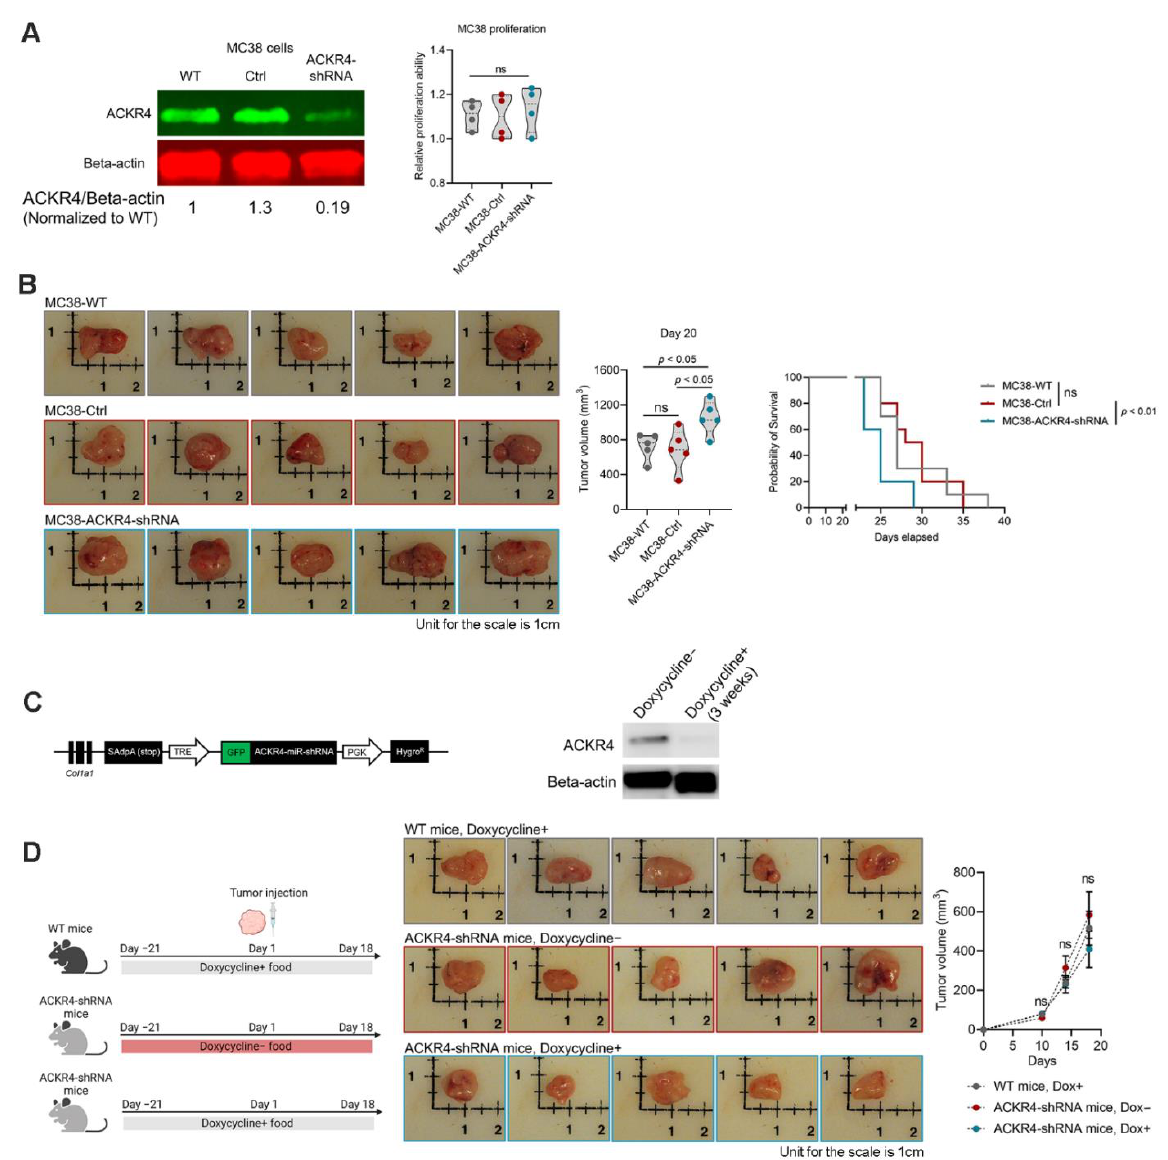
Figure 2. ACKR4 expression and tumor development. ( A ) Western blot analysis of ACKR4 knockdown in MC38 cell line (The grey area defines the data distribution. The dot lines in the violin plots indicate quartiles). ( B ) Knockdown of ACKR4 accelerated MC38 tumor growth in naïve C57BL/6J mice ( n = 5 for tumor growth analysis and n = 10 for survival analysis). ( C ) The induction and confirmation of ACKR4 knockdown in transgenic mice. Doxycycline treatment for 3 weeks significantly reduced ACKR4 expression in the mouse skin and subcutaneous connective tissue. ( D ) Knockdown of ACKR4 in the host mice did not significantly affect MC38 tumor growth ( n = 5). (For more than two group statistical analyses, the uppermost p -value indicates the ANOVA-analysis, and other p -values indicate the posthoc analysis between two specific groups. WT: Wild type, Ctrl: Control, shRNA: Short hairpin RNA, Dox: Doxycycline, Col1a1: Collagen, type I, alpha 1, GFP: Green fluorescent protein, Hygro R : Hygromycin resistance, PGK: Phosphoglycerate kinase, TRE: Tetracycline response element, ns: No significance, ANOVA: Analysis of variance). Detailed information about the Western blotting can be found in Figures S4 and